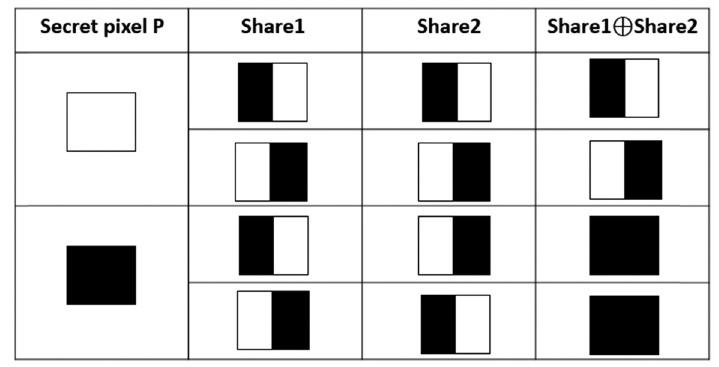
Figure 1: ( 2,2 )- VCS with ( 2 subpixels ) scheme codebook [ 2 ]